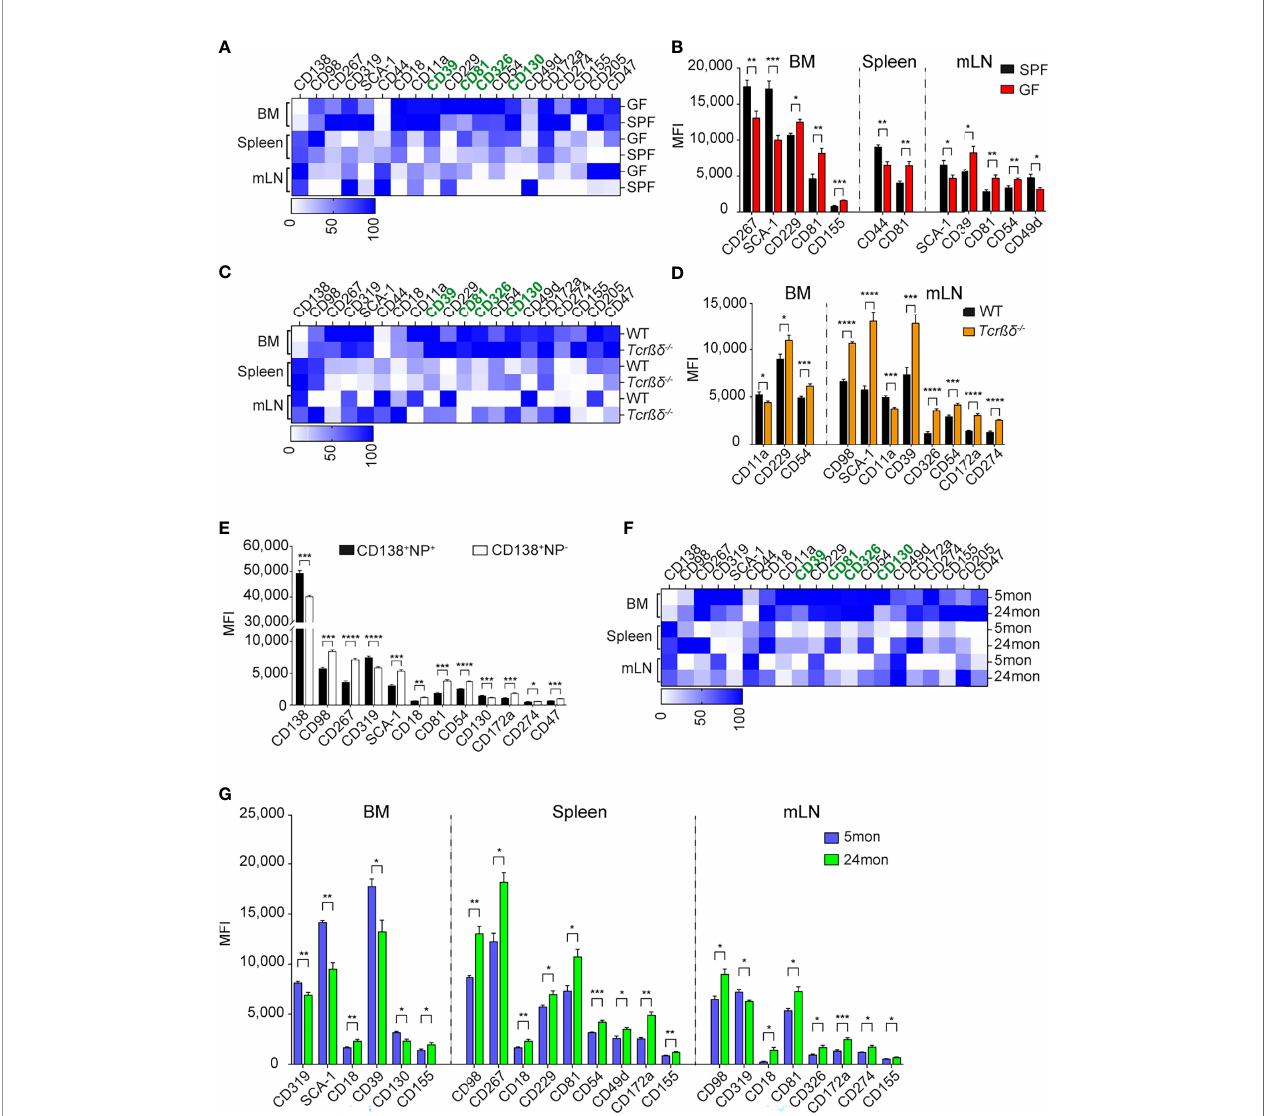
FIGURE 5 | Microbial and T-dependent signals are involved in the regulation of the newly identi fi ed markers on ASCs. (A, C, F) Heat map showing the expression level of indicated markers by CD138 + CD39 + ASCs from BM, spleen, and mLN of GF versus SPF mice (A) , Tcr bd -/- versus WT mice (C) , and 5 versus 24 months old mice (F) . Data are presented as percentages obtained by normalizing the MFI values of each marker among six indicated ASC populations using GraphPad Prism 9. Zero and 100 percent were de fi ned as the smallest and largest mean in each data set, respectively. (B, D, G) Expression level (MFI) of indicated markers by CD138 + CD39 + ASCs from BM, spleen, and mLN of GF versus SPF mice (B) , Tcr bd -/- versus WT mice (D) , and 5 versus 24 months old mice (G) (markers lacking signi fi cant differences are not shown). (E) C57BL/6 mice were immunized with 200µg NP-KLH, and splenocytes were analyzed 7 days later. Distinct expression (MFI values) of the indicated markers expressed on NP-reactive versus non-NP-reactive ASCs identi fi ed as shown in Supplementary Figure 5D . Data show compilation of at least two independent experiments (n=5-9 mice/group). Groups were compared using multiple unpaired t test with Welch correction followed by Holm-S ̌ ida ́ k ’ s multiple comparisons test. Data show mean ± SEM ( ∗ p < 0.05, ∗∗ p